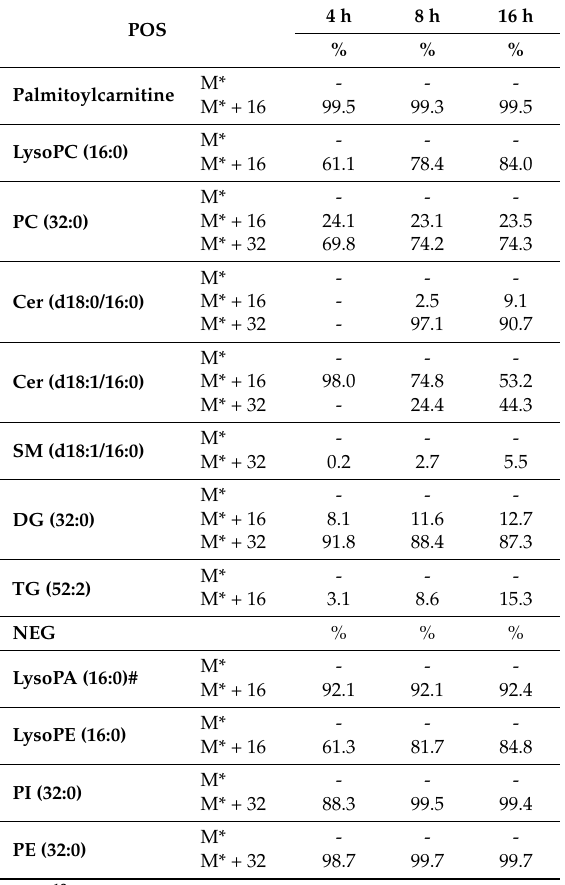
Table 1. Metabolites were isotope labeled in 13 C16-palmitic acid-treated ( 13 C16:0) HepG2 cells.